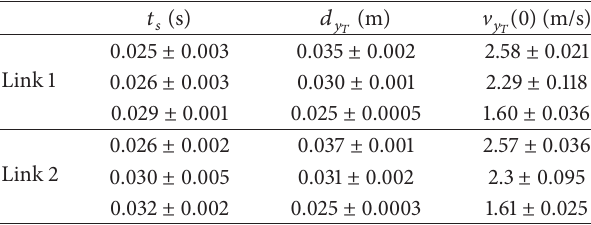
Table 2: The experimental results for the two end points of the double kinematic chain.